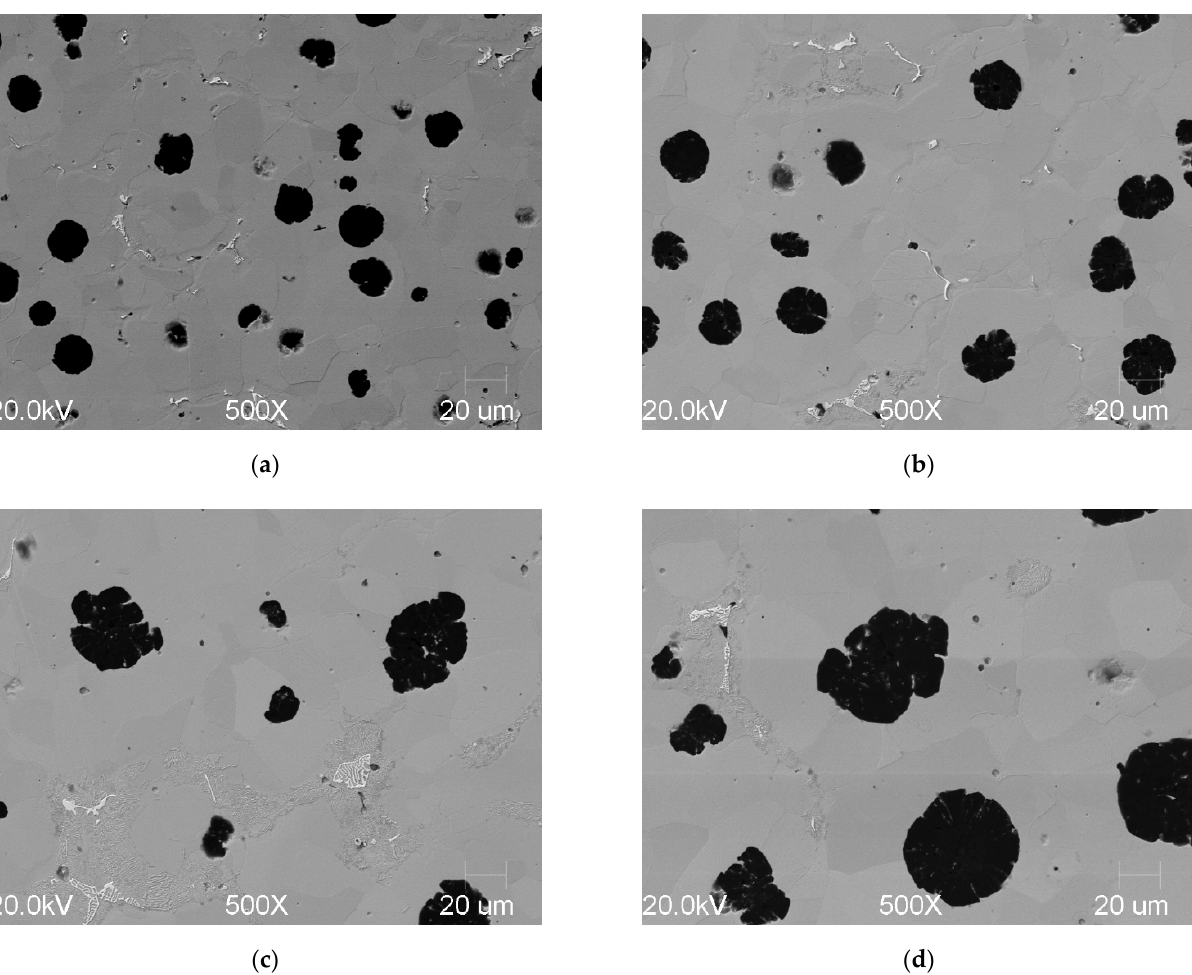
Figure 5. SEM microstructure of Si–Mo ductile iron in castings with different wall thicknesses: ( a ) 3 mm; ( b ) 5 mm; ( c ) 13 mm; and ( d ) 25 mm. Nital-etched samples.